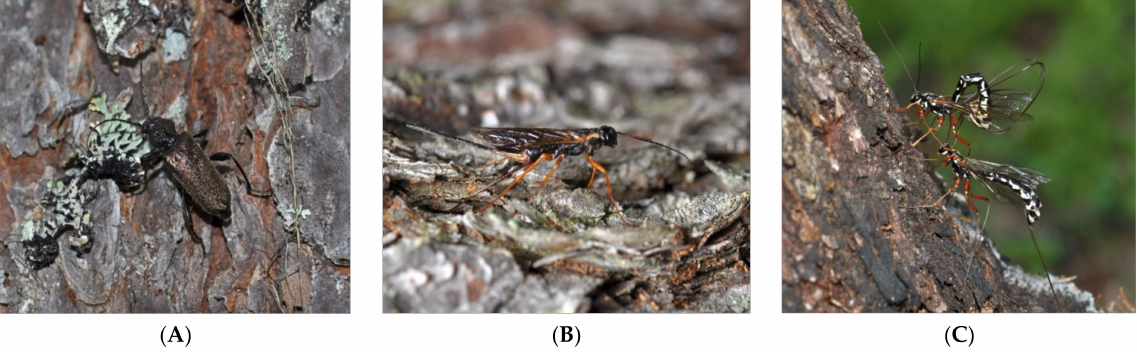
Figure 7. Xylobiotic insects: longhorn beetle Callidium coriaceum ( A ), horntail Xeris spectrum ( B ), ichneumon wasp Megarhyssa rixator ( C